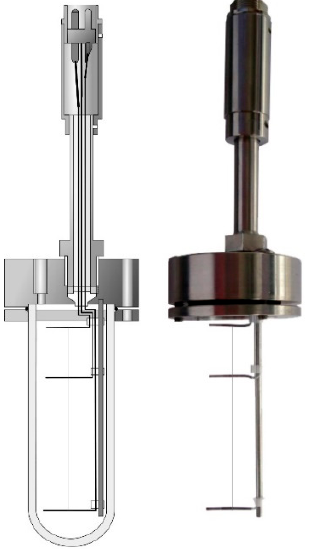
Figure 4. Hot-wire cells developed by Antoniadis et al. [36] for the measuring of the thermal conductivity of electrically conducting nanofluids. Tantalum (99.9%) wire (25 µ m, long wire length 50 mm and short compensating wire length 20 mm) coated with an anodic layer of Ta 2 O 5 . The global uncertainty of the measurement, at a 95% confidence level, was estimated to be U λ = 1%. Courtesy of the authors.